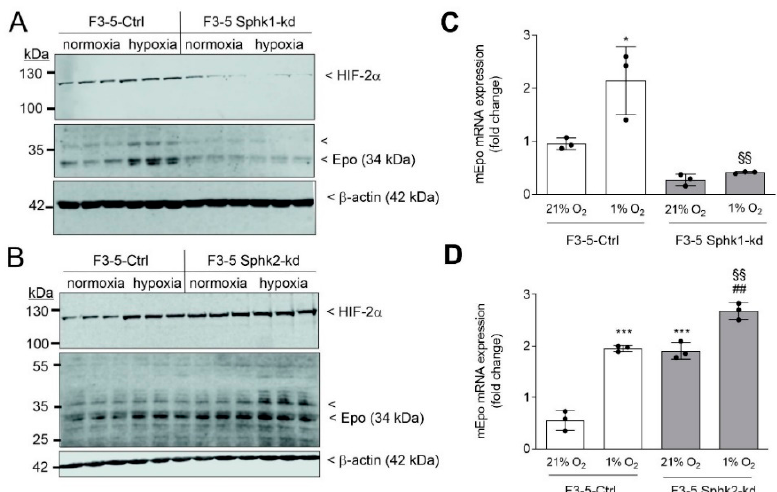
Figure 2. Sphk1- and Sphk2-knockdown in F3-5 cells affects hypoxia-induced HIF-2 α protein and Epo mRNA and protein levels. Control F3-5 cells (Ctrl), or cells stably downregulating mSphk1 ( A , C , Sphk1-kd) and mSphk2 ( B , D , Sphk2-kd) were exposed for 6 h to normoxia (21% oxygen) or